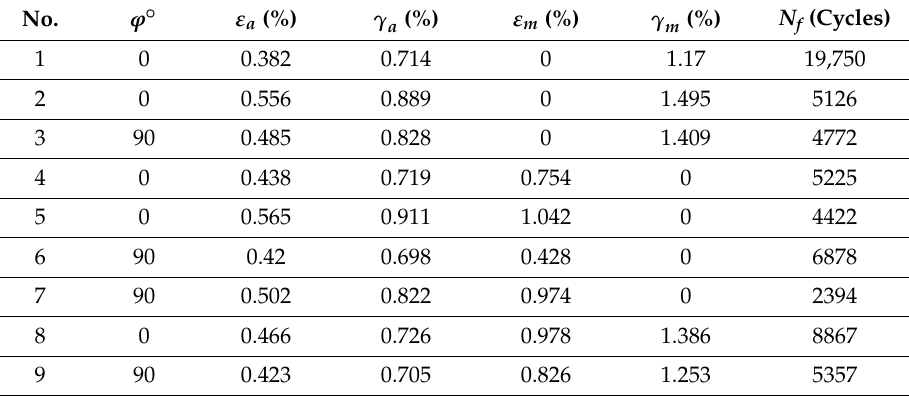
Table 4. Fatigue test data of TC4 for asymmetric